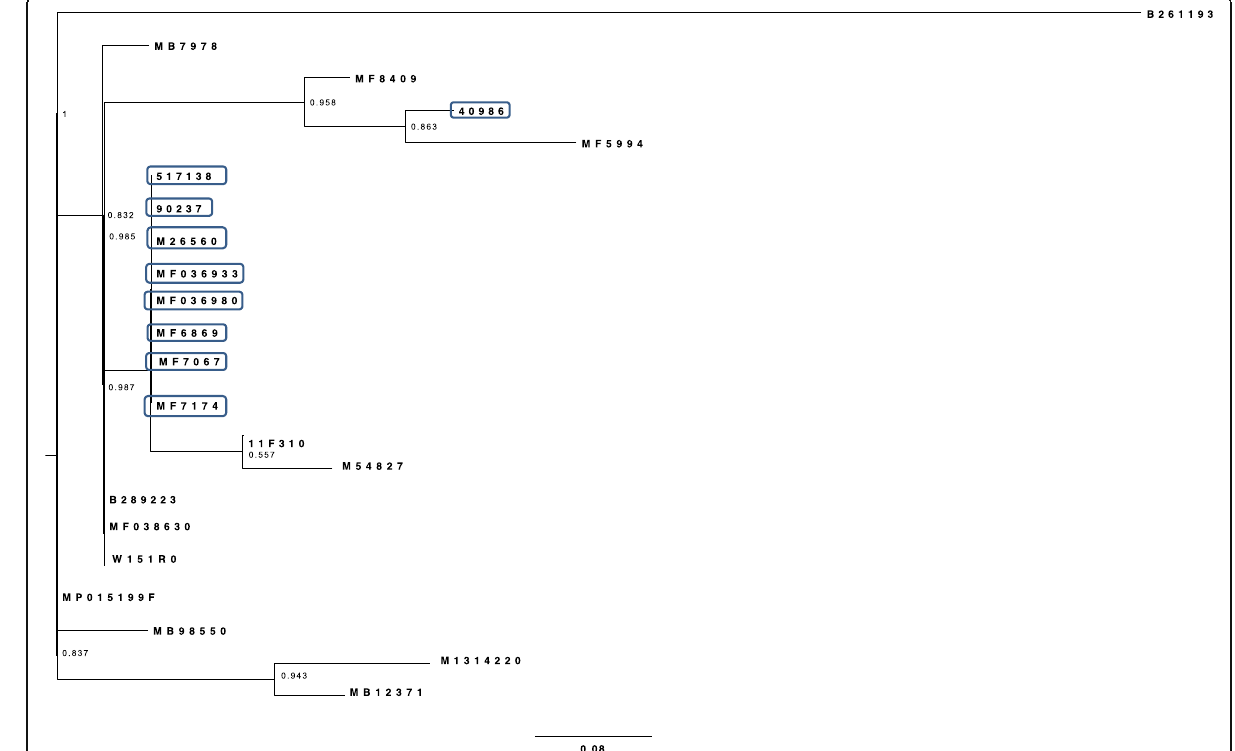
Fig. 3 Maximum likelihood phylogenetic tree of Salmonella Dublin strains based on prophages SNPs using